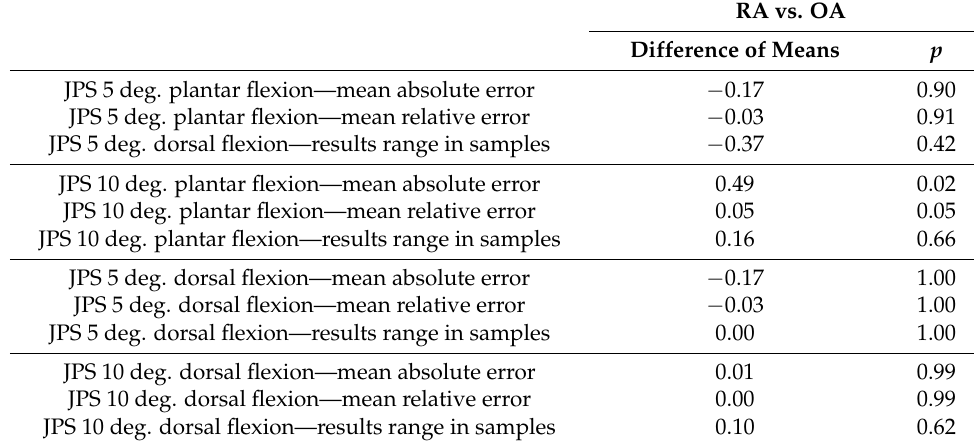
Table 2. Comparison of JPS in plantar and dorsal flexion motion of ankle joint between groups.